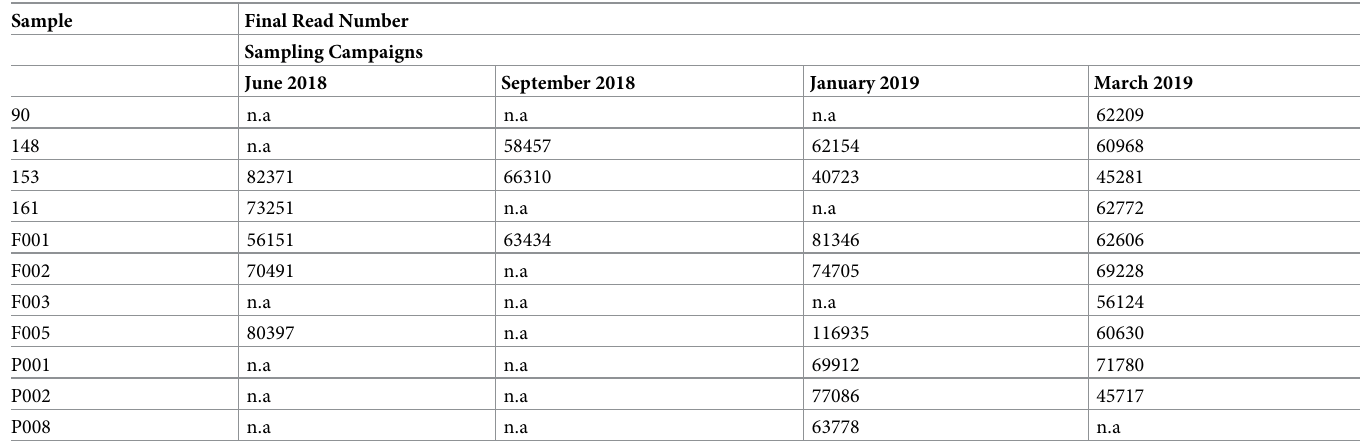
n.a. represents not available samples.